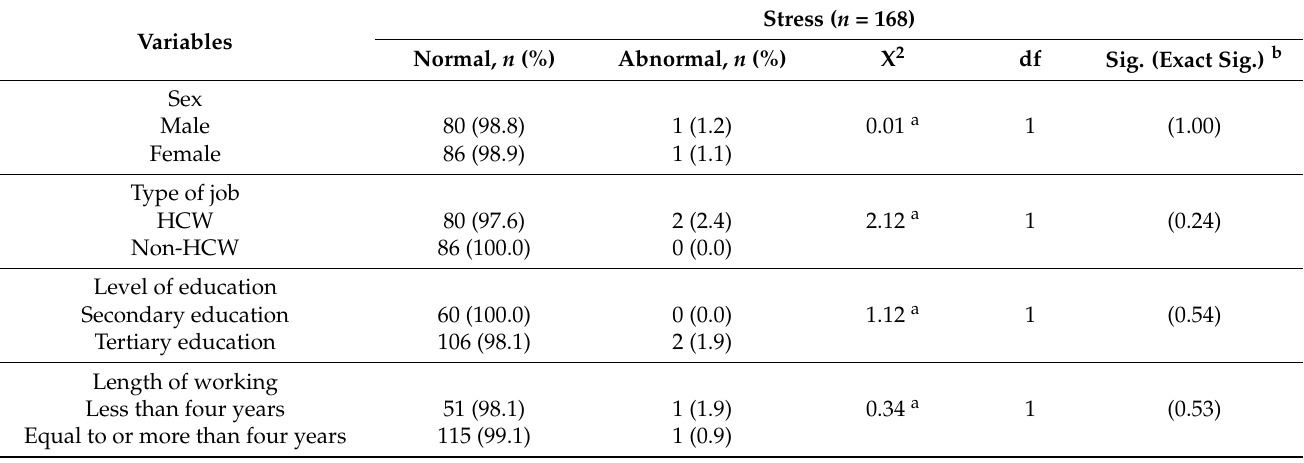
Table 7. Association between stress and sociodemographic and occupational information variables.